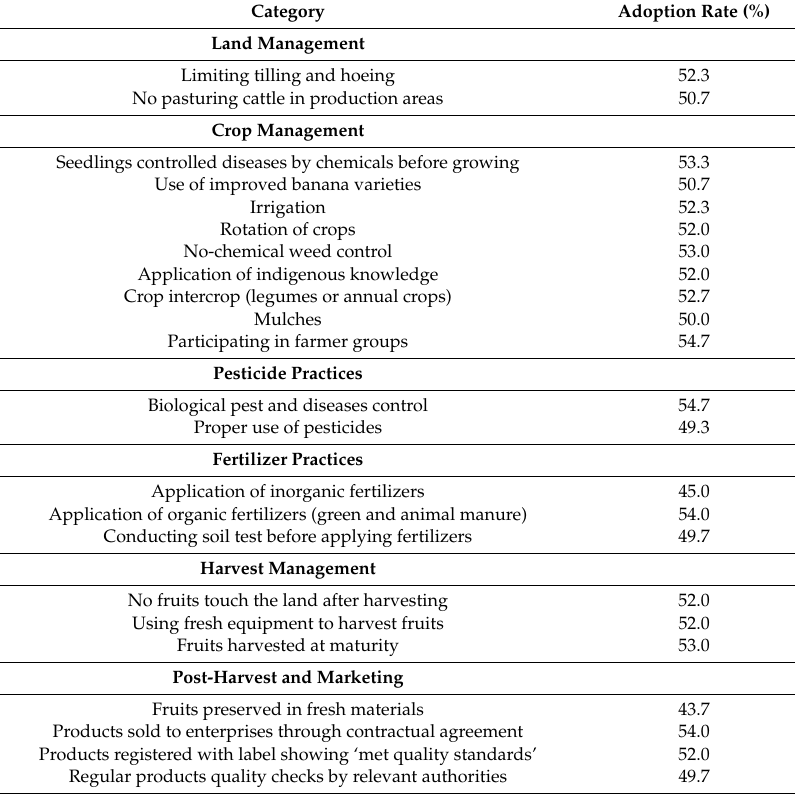
Table 2. Uses of measures during banana